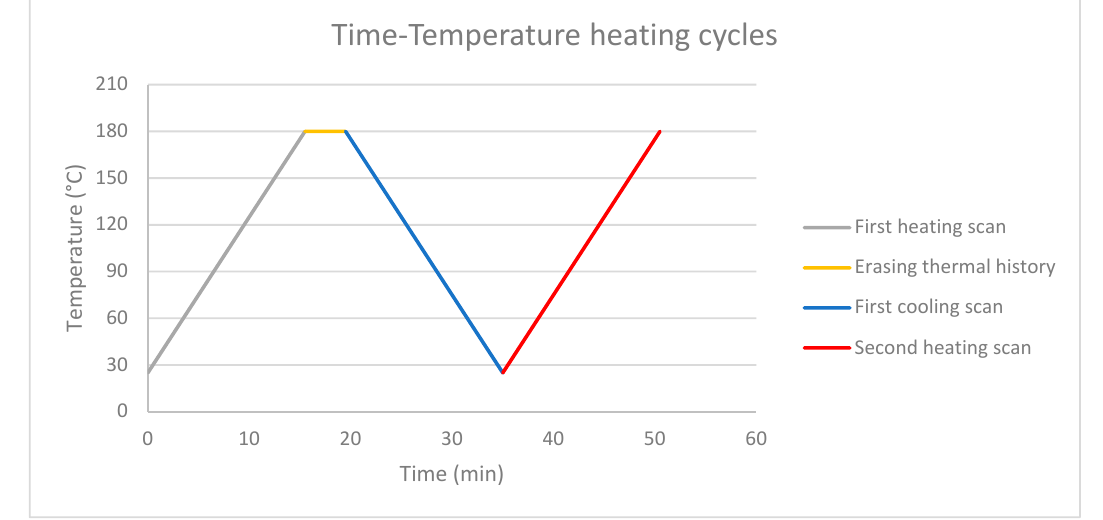
Figure 1. Differential Scanning Calorimetry heating cycle. Grey line is the first heating scan, yellow line is the interval to erase thermal history, blue line is the first cooling scan (evaluation of crystallization temperature Tc and crystallization enthalpy Δ Hc), red line is the second heating scan (evaluation of cold crystallization temperature Tcc, melting temperature Tf and melting enthalpy Δ Hf).